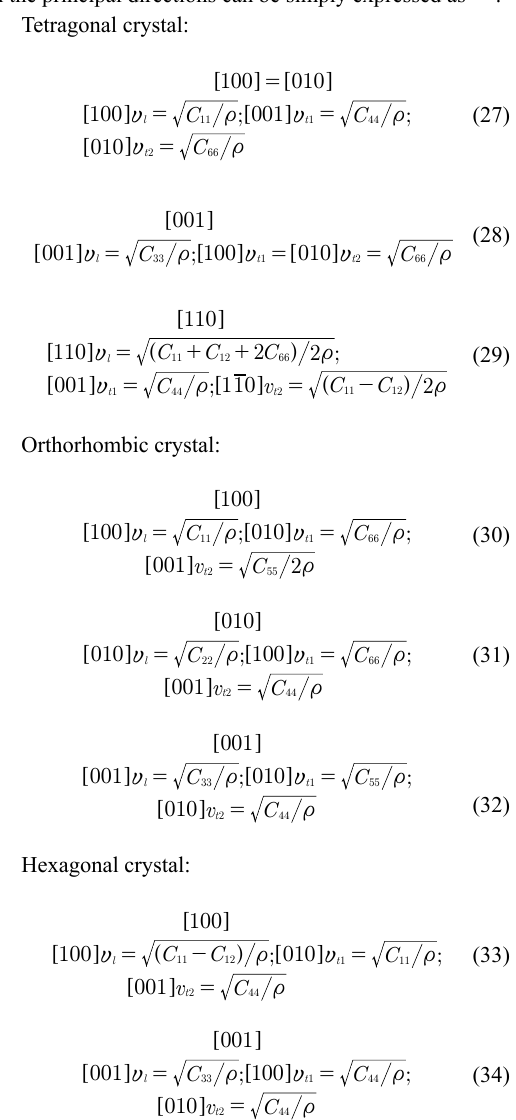
Table 5. The theoretical density (ρ, g/cm 3 ), longitudinal sound velocity (ν , m/s), shear sound velocity (ν l velocity (ν , m/s) of Ga Mg m x y